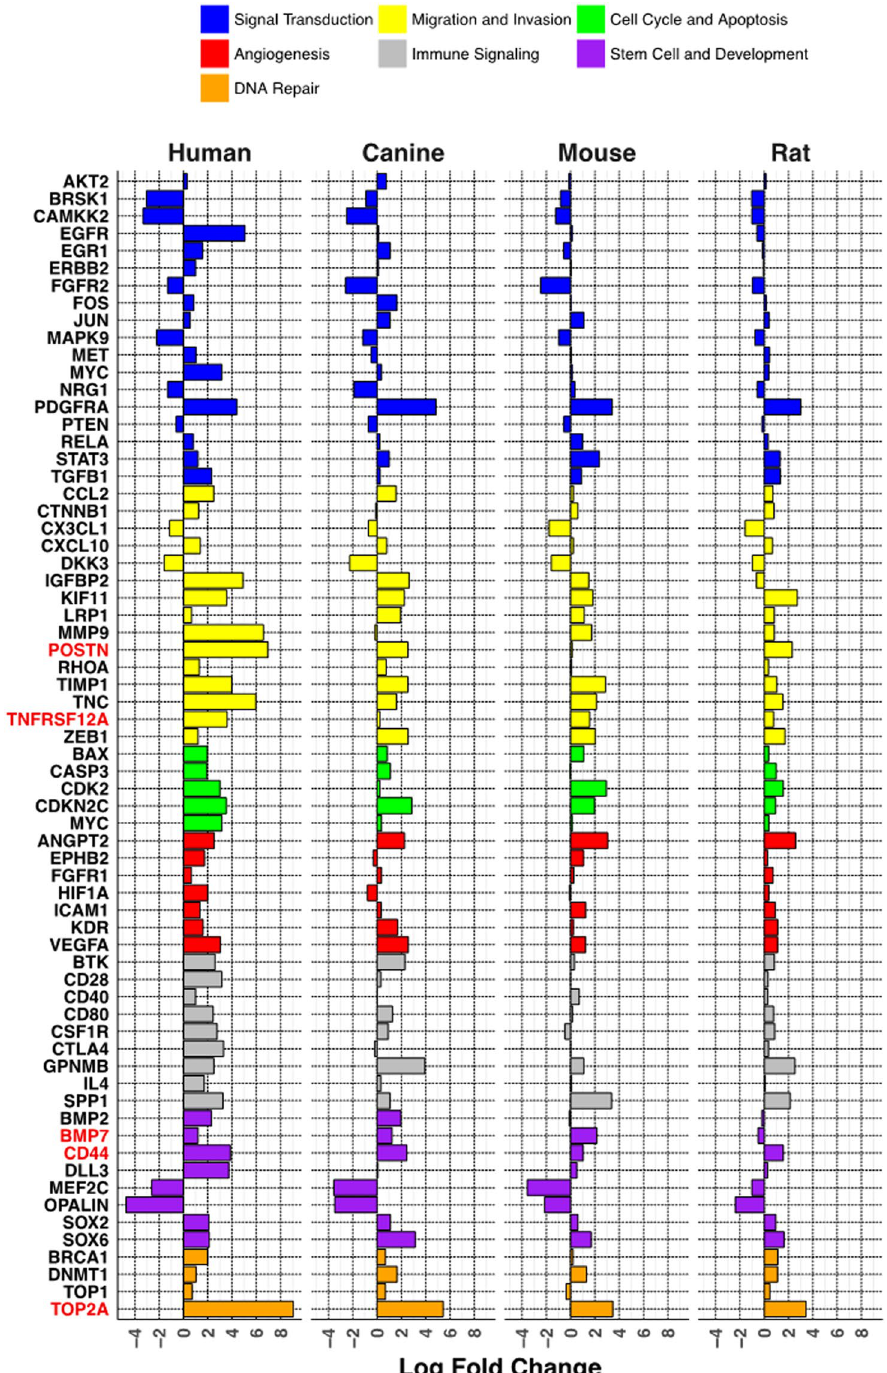
Figure 7. Comparative analysis of selected glioma signature gene expression patterns. A representative subset of the glioma-associated gene set used for the analysis in Fig. 6 was plotted by their log-fold change in each species. The individual genes were grouped by the predominant pathway to which they contributed. The expression pattern of the genes highlighted in red was analyzed at the protein level by immunofluorescence (Supplementary Figure